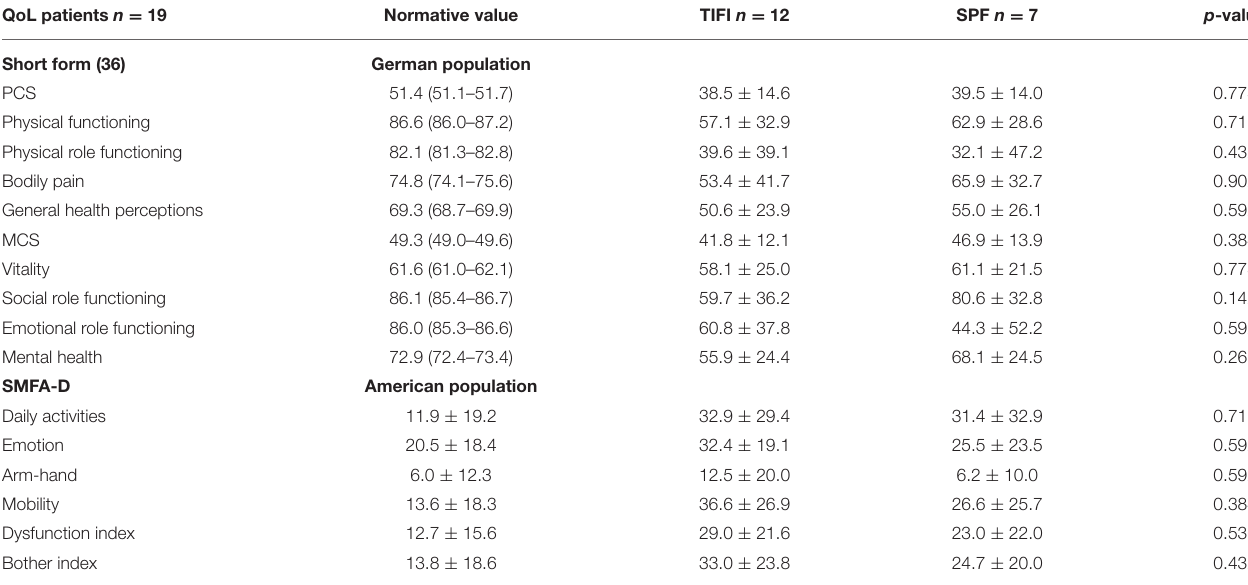
TABLE 4 | Quality of life (SF-36 and SMFA-D) after TIFI or